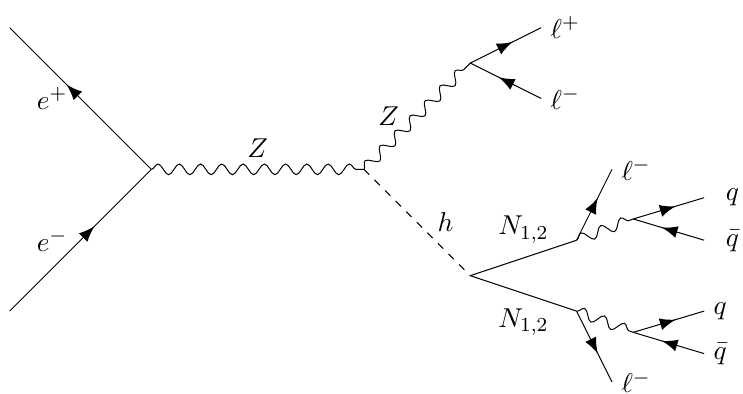
Figure 3 . Feynman diagram for 2 ‘ 4 q production in the SS leptons final state through Higgs- strahlung production.